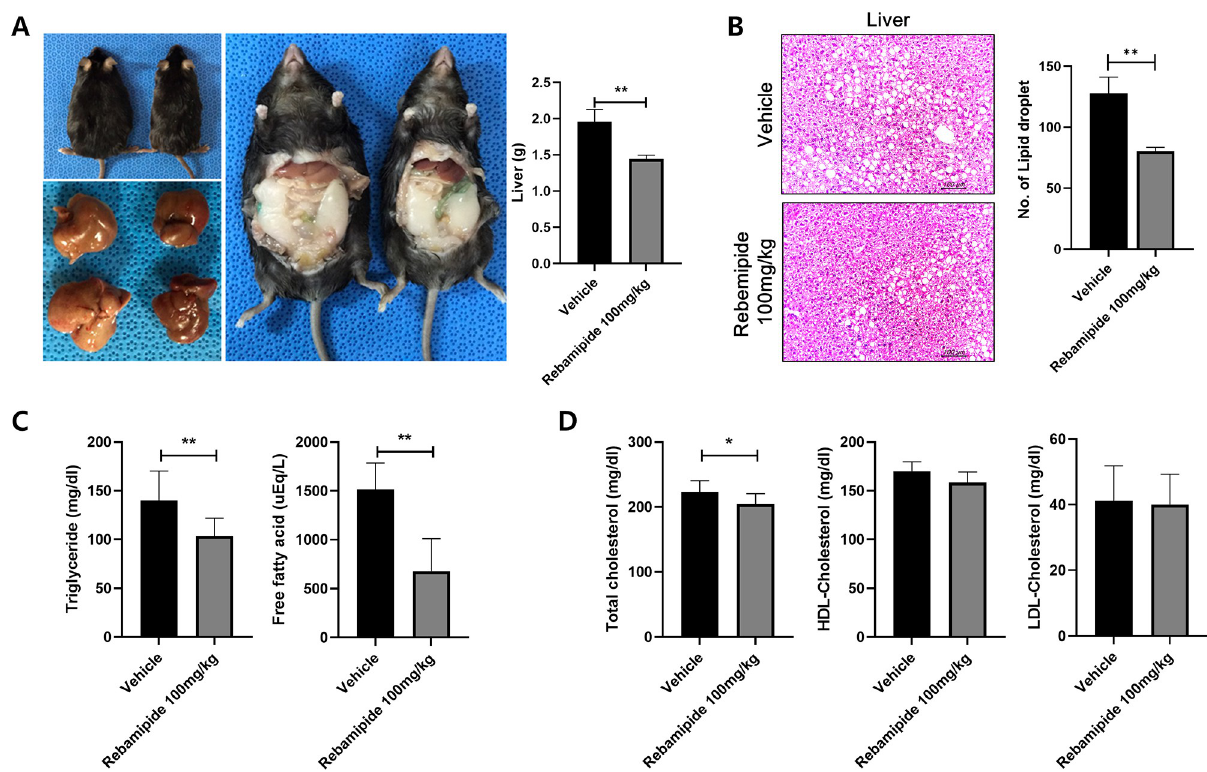
Fig 3. Rebamipide inhibits liver steatosis in mice. (A) Rebamipide decreased mouse body size, liver volume and liver weight. (B) The liver H&E images showed that rebamipide reduced the lpid droplet size in liver tissues. (C and D) The levels of triglyceride, free fatty acid, total cholesterol, high- density lipoprotein (HDL) and low-density lipoprotein (LDL) were monitored in the mice blood. � P < 0.05 and �� P <